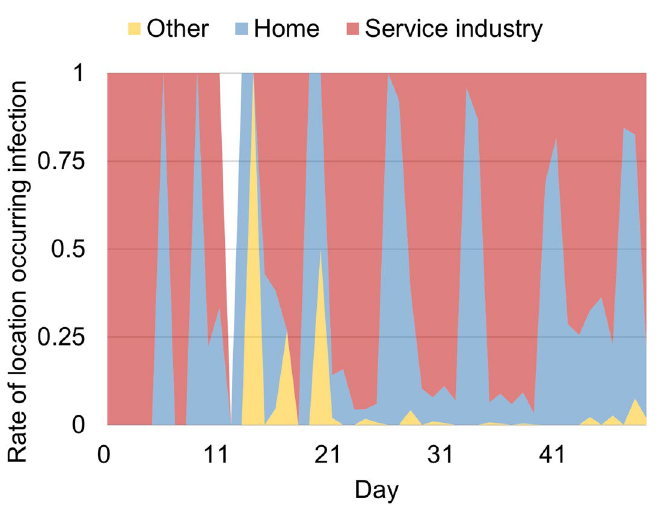
Figure 2. Frequency of people’s contacts by weekday/holiday and daytime/nighttime on the service facilities at areas where people are in frequent contact. Average value of contact frequency in Tokyo and the local reproduction number R t are also shown.